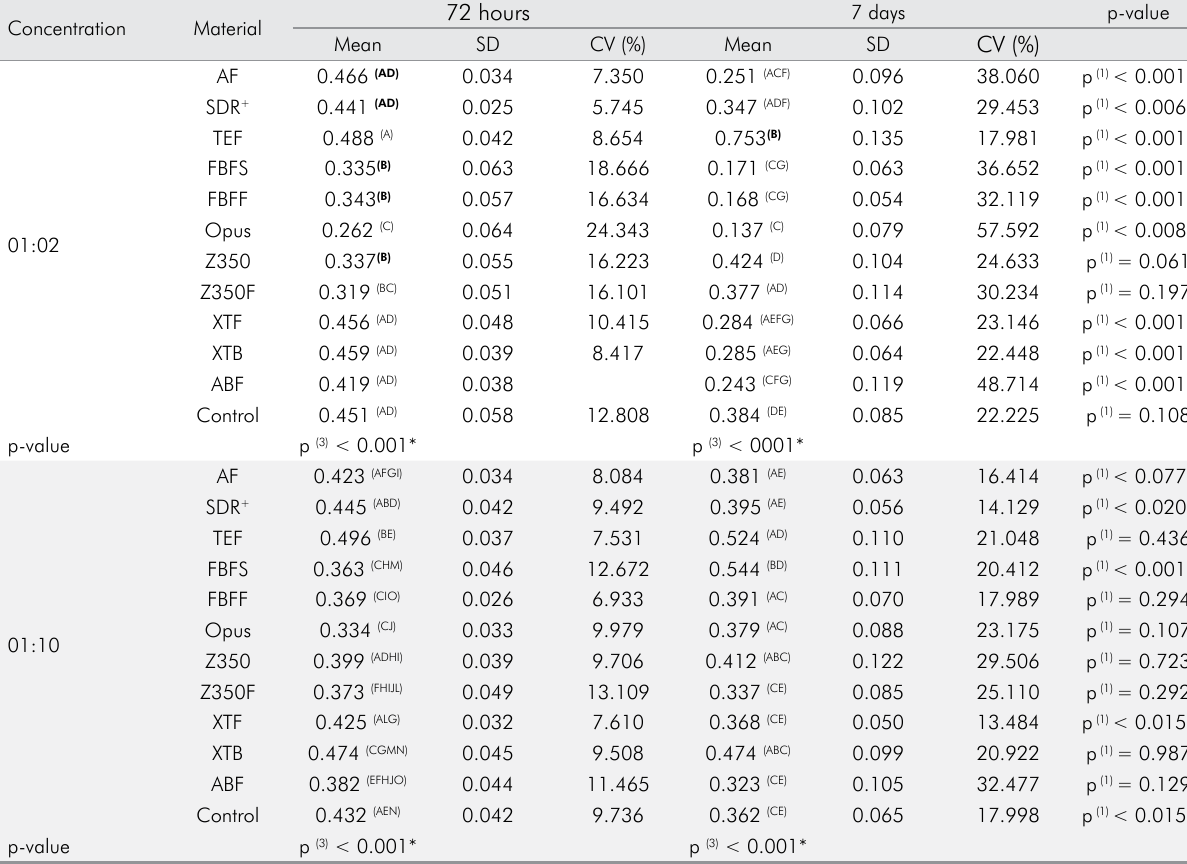
Table 3. Mean ± standard deviation of neutral red according to material, concentration and days of evaluation. Concentration